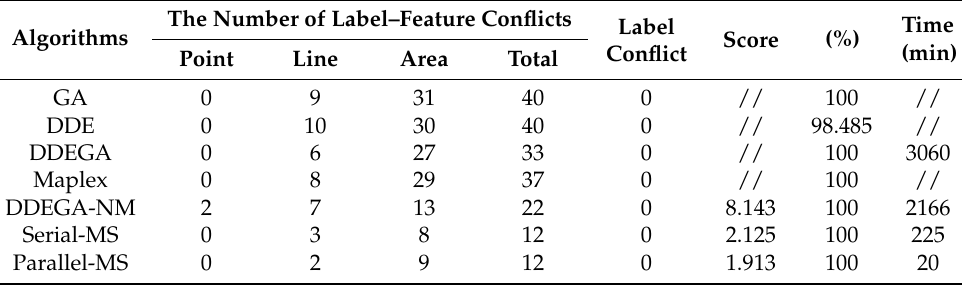
Table 4. Comparison of the proposed algorithm with previous algorithms on the first dataset.